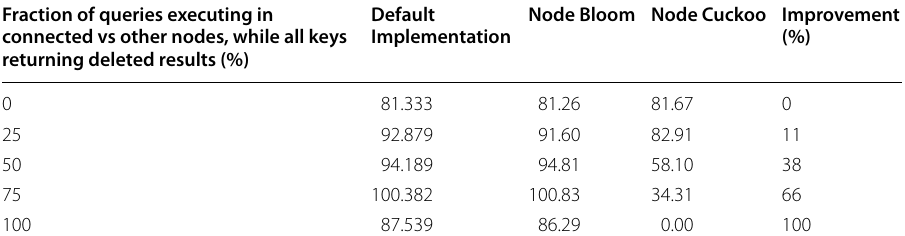
Table 7 Experimental results 2: lookup performance after data deletion. Query execution time in seconds Fraction of queries executing in connected vs other nodes, while all keys returning deleted results (%)